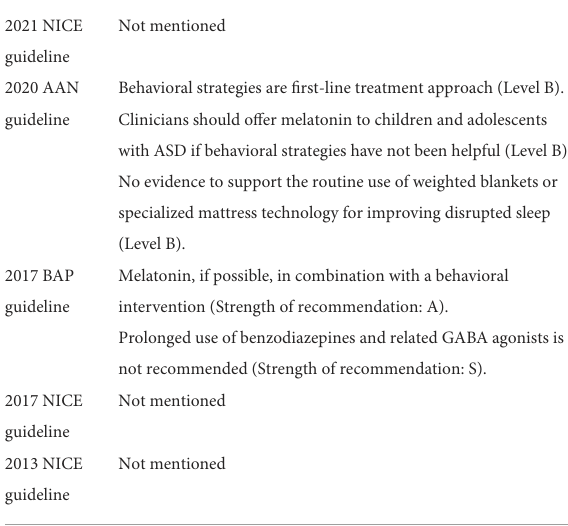
TABLE 1 Summary of clinical guidelines for the treatment of sleep disorders in children with autism spectrum disorders. Guidelines Recommendations of treatment for